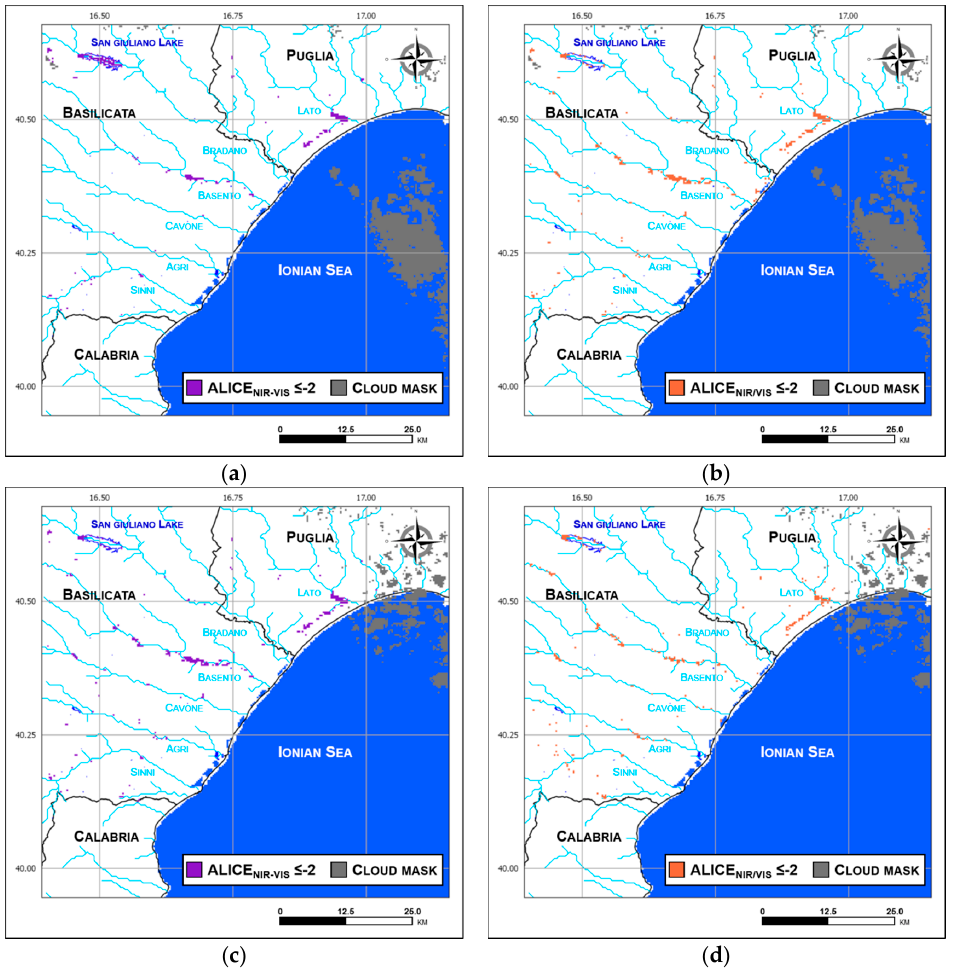
Figure 5. Anomalous pixels detected by Visible Infrared Imaging Radiometer Suite (VIIRS)-based RST-FLOOD using: ( a ) ALICE NIR-VIS , ( b ) ALICE NIR/VIS on 4 December 2013 at 12:10 GMT and ( c ) ALICE NIR-VIS , ( d ) ALICE NIR/VIS on 5 December 2013 at 11:50 GMT.